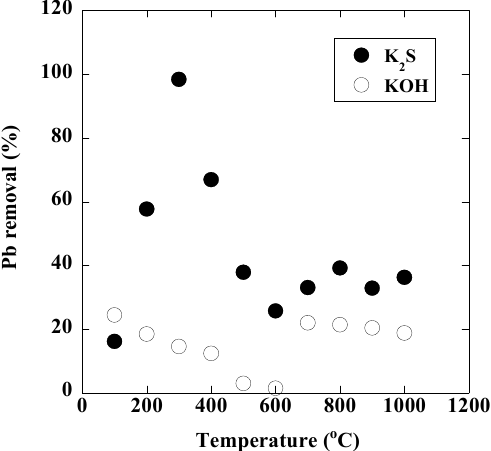
Figure 3. Lead removal abilities of Product-K 2 S and Product-KOH.